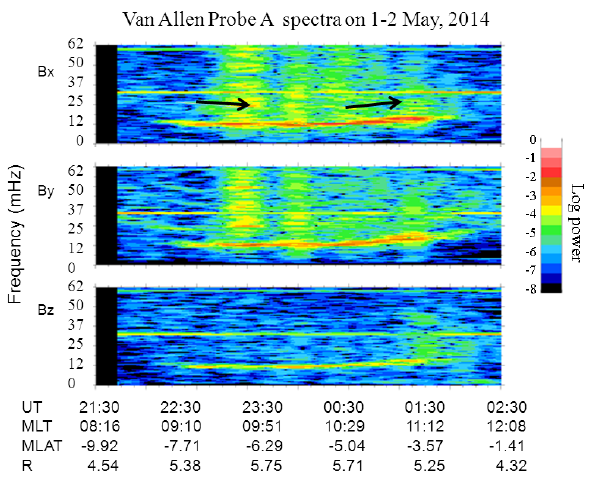
Figure 10. Dynamic spectra calculated for the radial, azimuthal and compressional components of the Van Allen Probe A magnetic field during the Orbit 3 from 21:30 to 02:30UT on 1–2 May 2014. The location of the satellite is shown in the bottom where R is the radius of Earth, MLAT is magnetic latitude in degrees and MLT is the magnetic local time in hours.